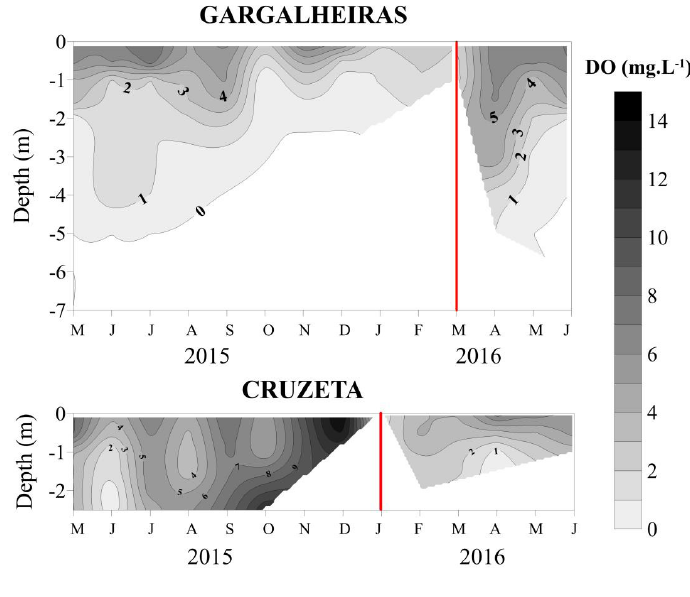
Figure 3. Vertical Profiles of dissolved oxygen (DO) of the reservoirs Gargalheiras and Cruzeta, in the period of May 2015 to June 2016. The red line is indicating the highest rainfall in the period, which contributed to the increase in water depth, as can be seen in the